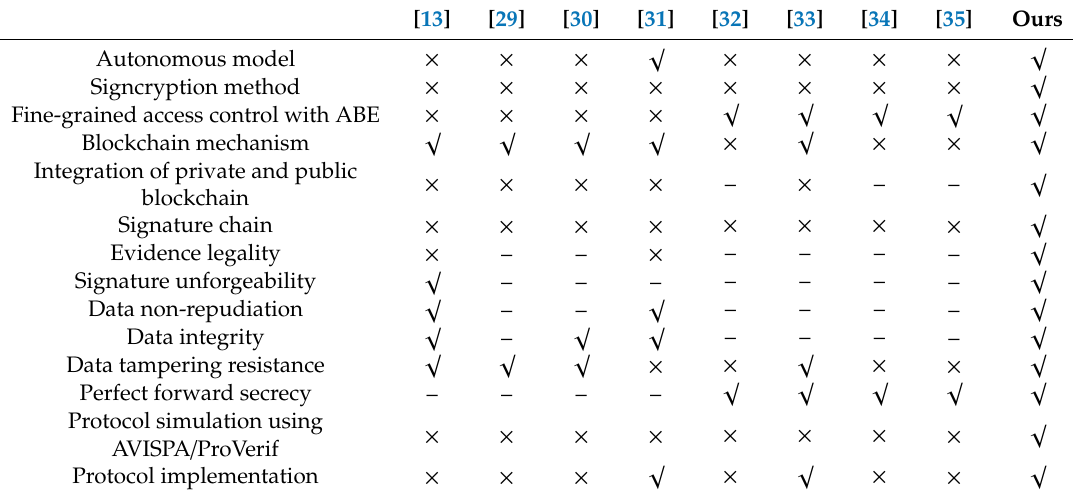
Table 4. Comparison on security and functionality of our work and related